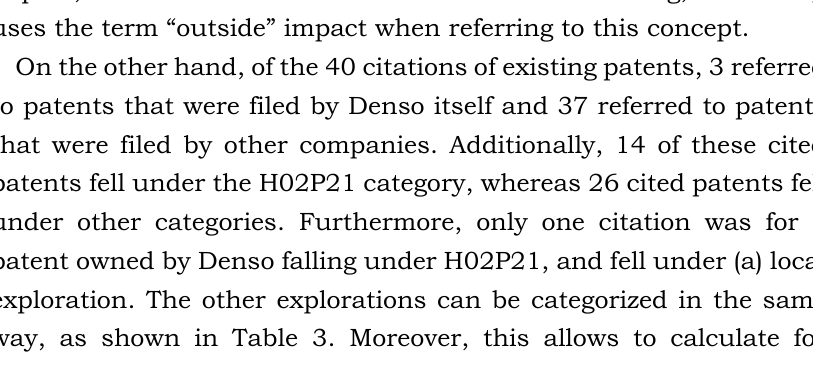
Table 3. Four types of exploration of “Denso 2011” using